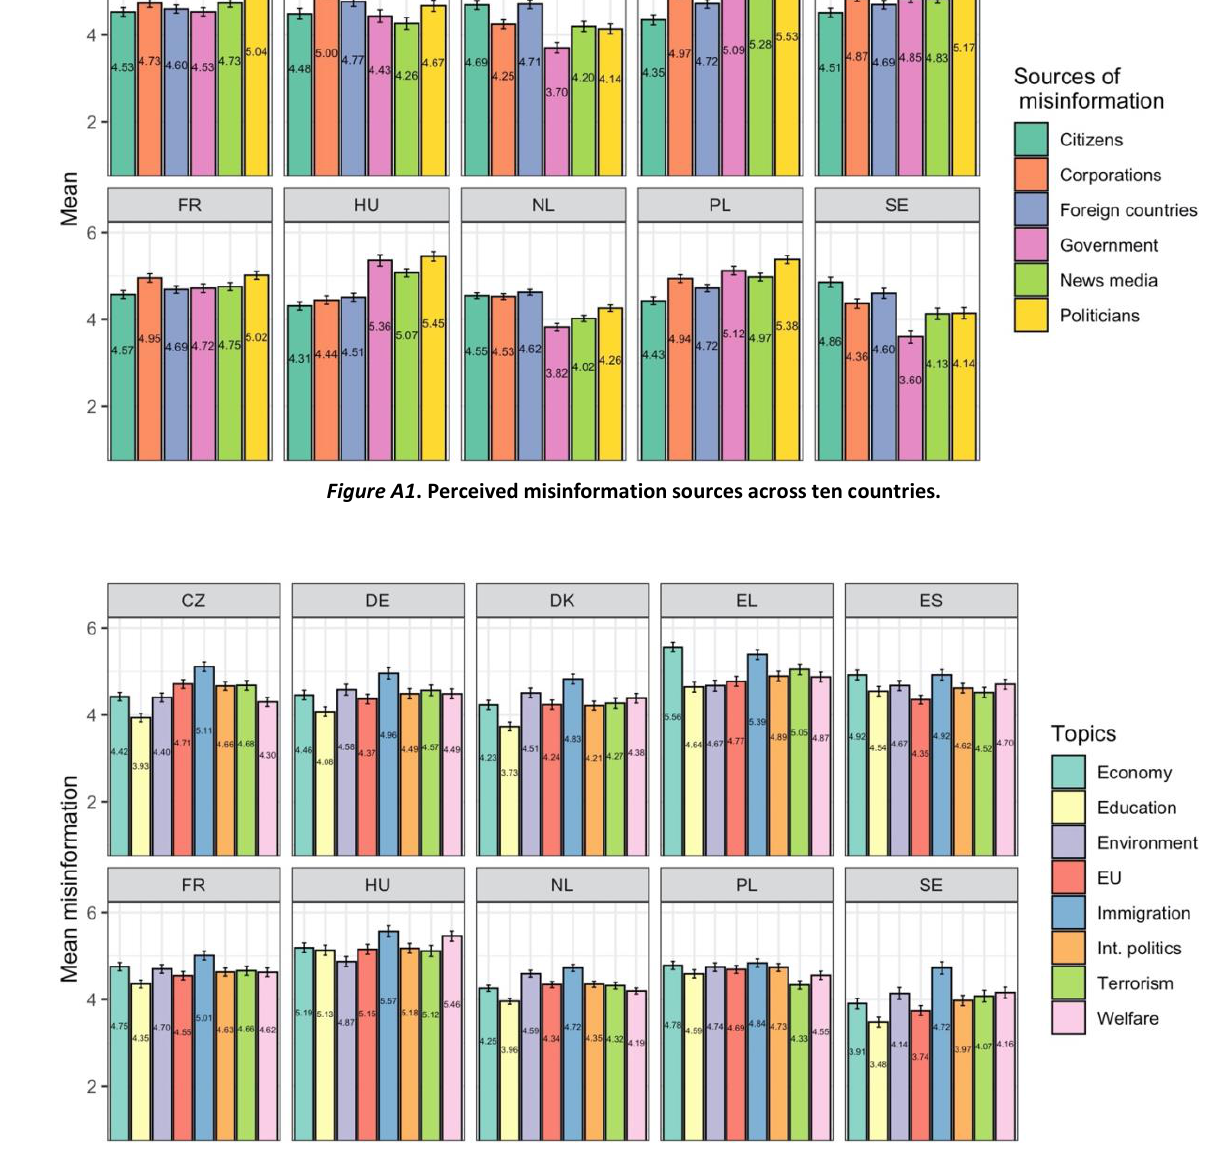
Figure A2 . Perceived misinformation topics across ten